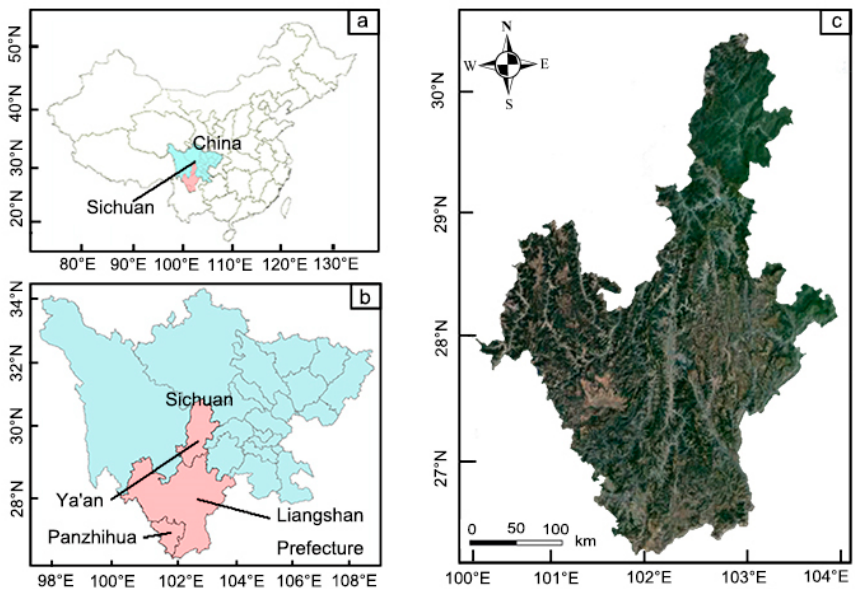
Figure 1. Location of the study area: ( a ) Sichuan province in China; ( b ) the study area; ( c ) an aerial photograph of the study area.